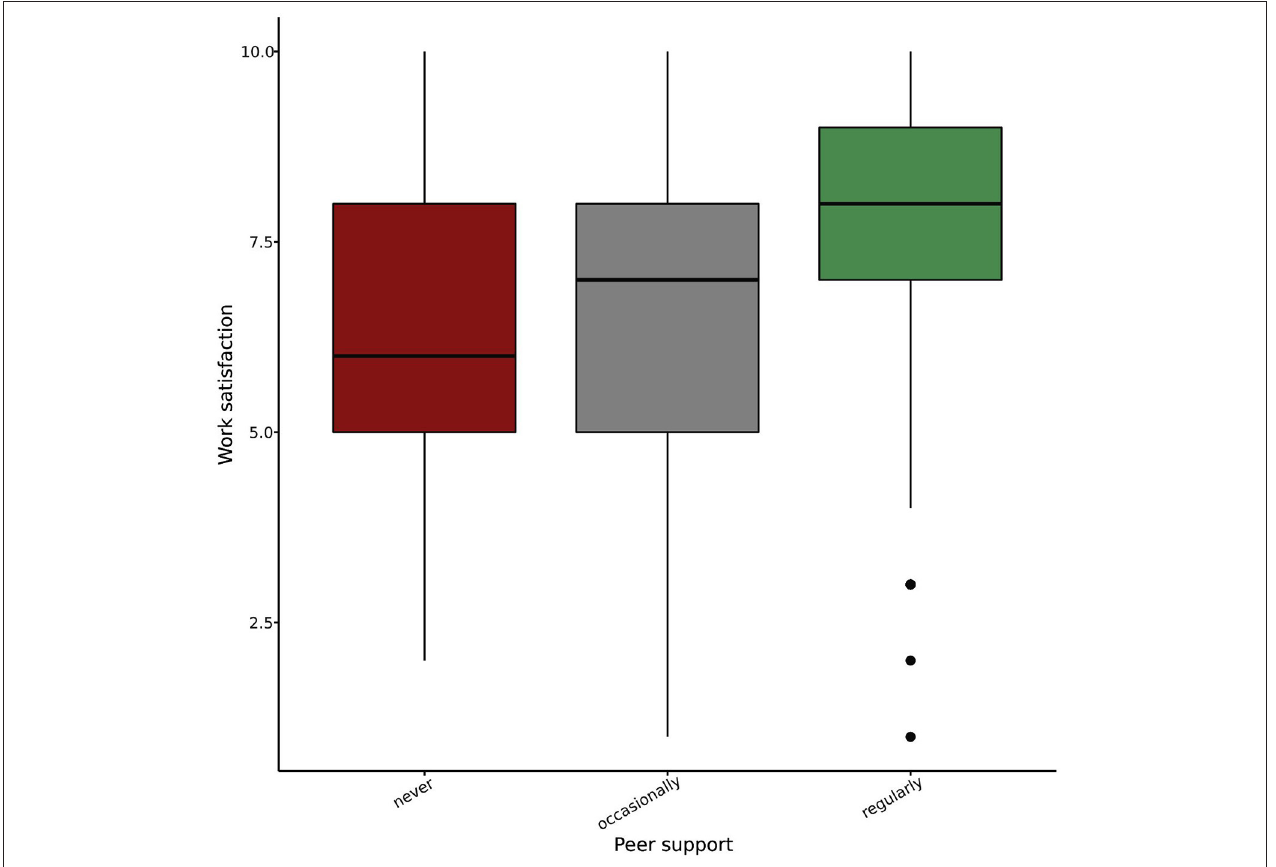
FIGURE 7 | Job satisfaction grouped by the frequency by which pediatricians report to receive peer support in demanding clinical